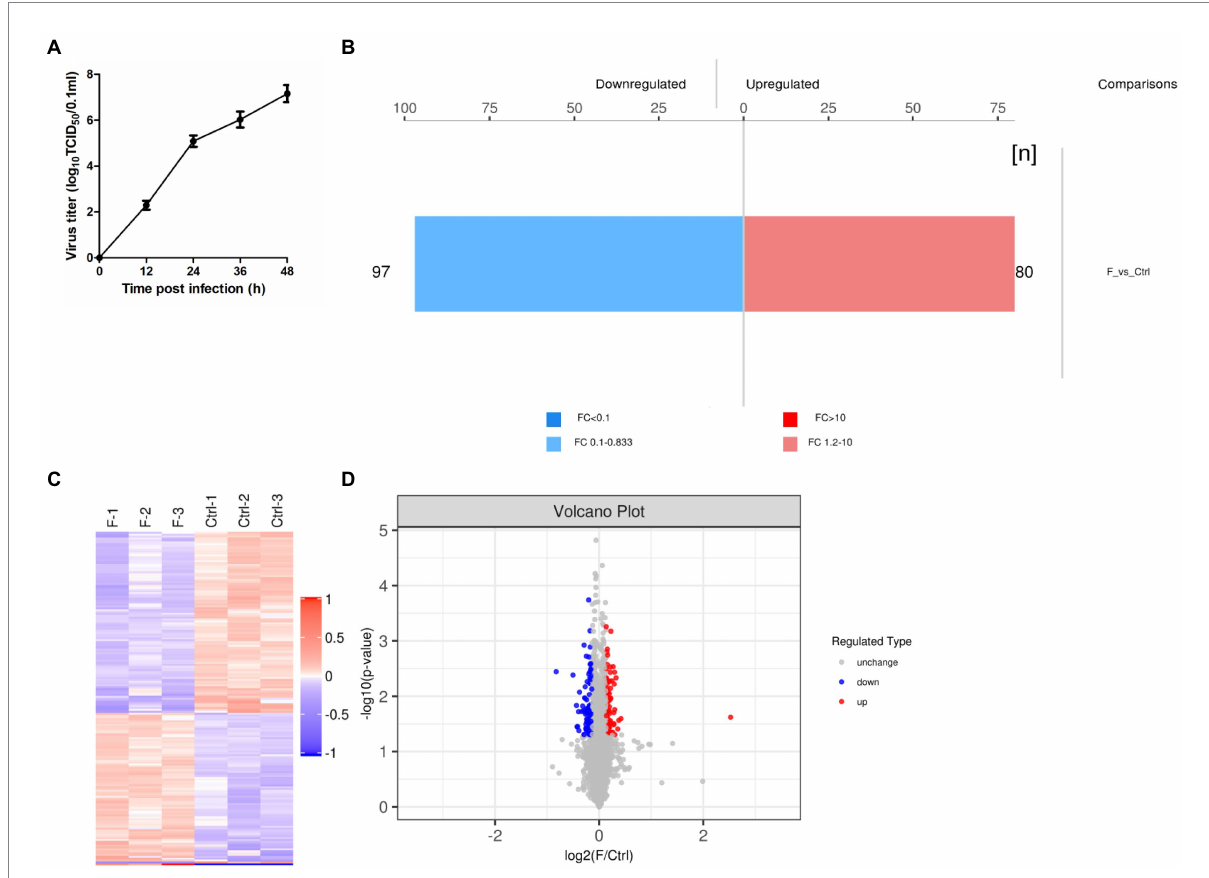
FIGURE 1 FAdV-4 induction of differentially expressed proteins (DEPs) in LMH cells at 24 hpi ( p < 0.05, |log 2 (fold-change)| > 1.2). (A) One-step growth curve of FAdV-4 in LMH cells. (B) Histogram of protein quantitative difference results. (C) The heatmap shows the protein expression patterns, and the volcano plot displays the number of DEPs. (D) Volcano plots of DEPs between control and FAdV-4 groups. X -axis: base-2 logarithm of fold- change (experimental group/control group); y-axis: negative logarithm of p